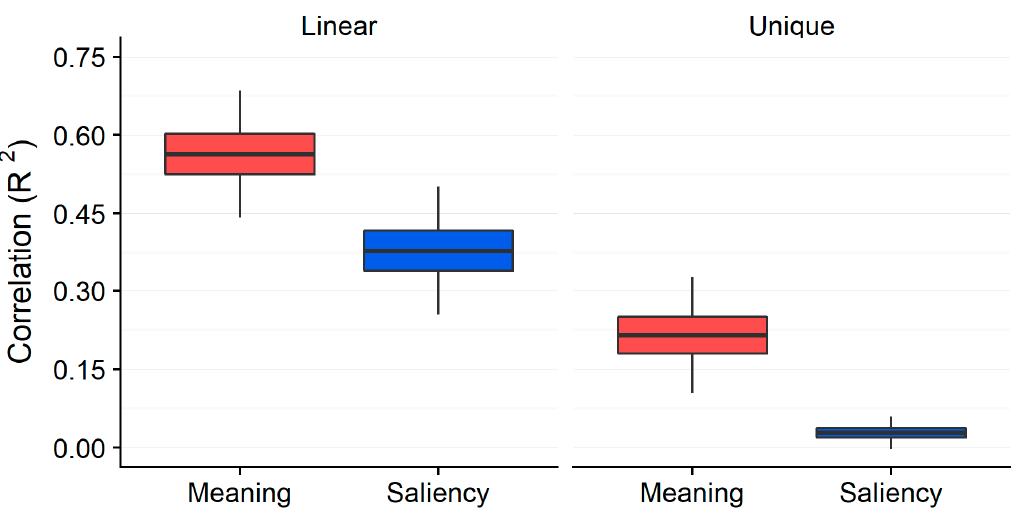
Figure 4. Squared linear correlation and semi-partial (unique) correlation for meaning and image salience across 40 scenes from a scene memorization task in Henderson and Hayes (2017) [42]. Box plots show the grand mean (black horizontal line), 95% confidence intervals (colored box), and one standard deviation (black vertical line).